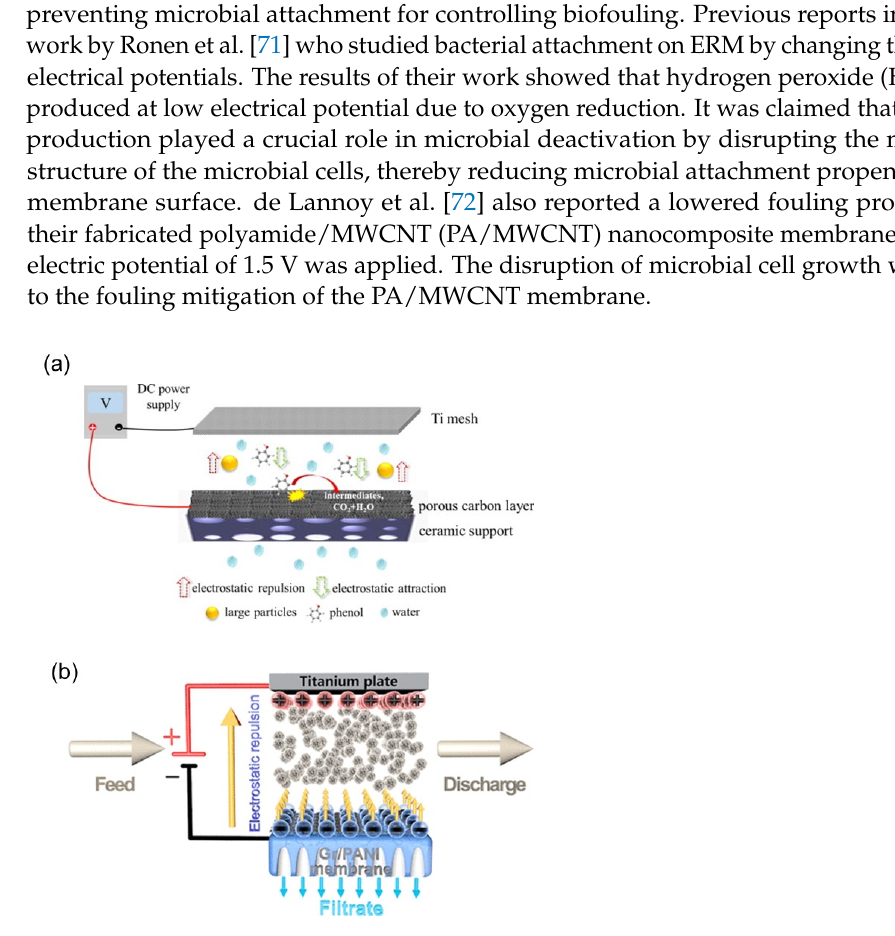
Figure 5. Fouling mitigation by electrically responsive membranes, ( a ) as illustrated by Chen et